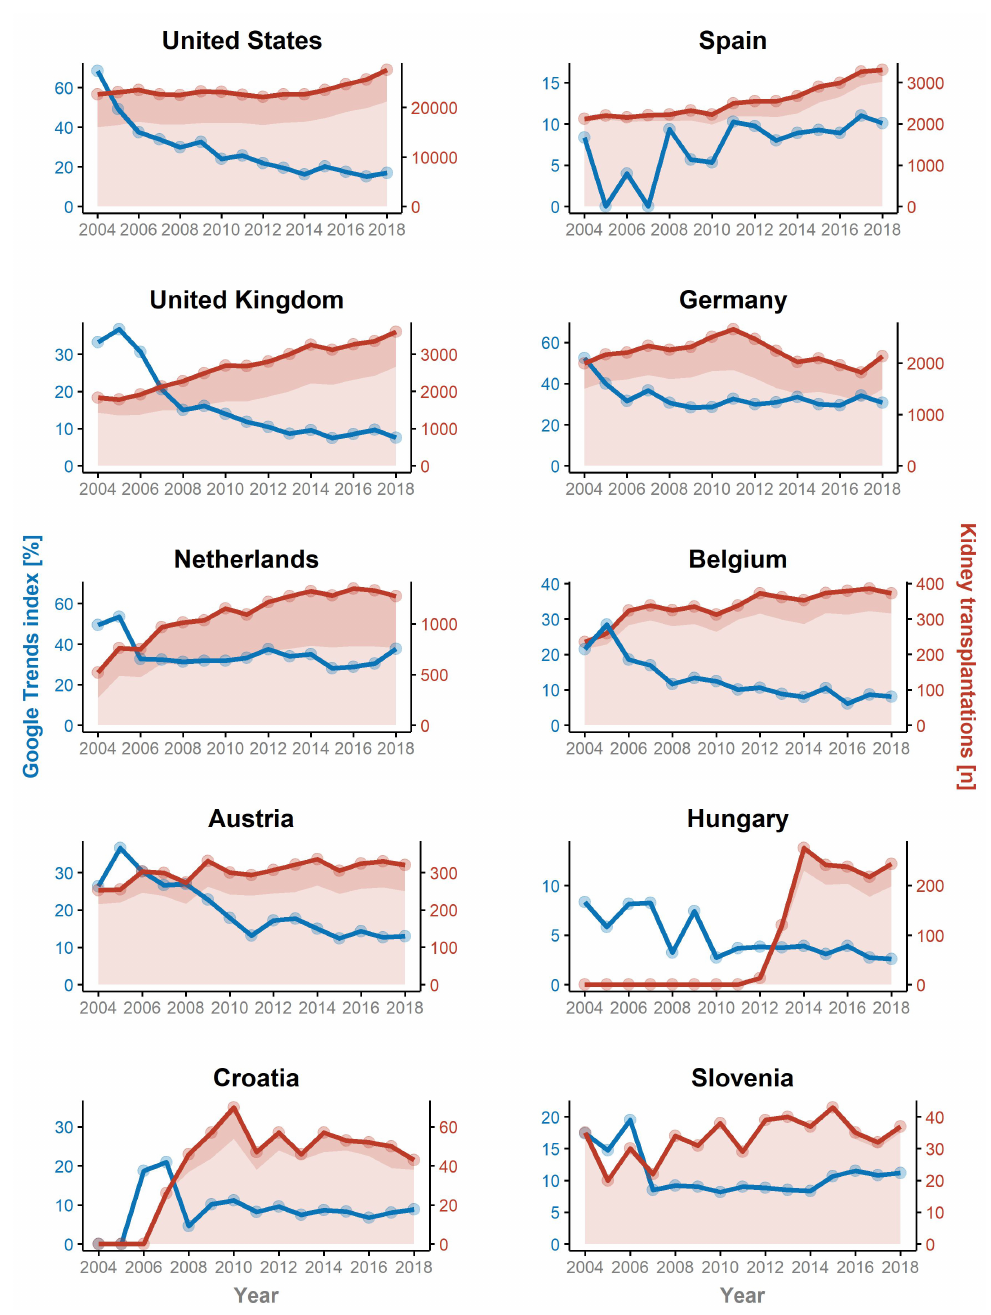
Figure 2. The respective numbers of renal transplants (red line) and the Google Trends TM indices (blue line) are given for the United Nations of Organ Sharing (UNOS), the Organizaci ó n Nacional de Trasplantes (ONT), the Eurotransplant areas, and the UK National Register. Numbers of deceased and living donor transplants are indicated by light and dark red areas. While there was a marginal increase in the Google Trends TM index observed in Spain, the curves obtained from the UNOS, Eurotransplant areas, and the UK National Register mirror the worldwide